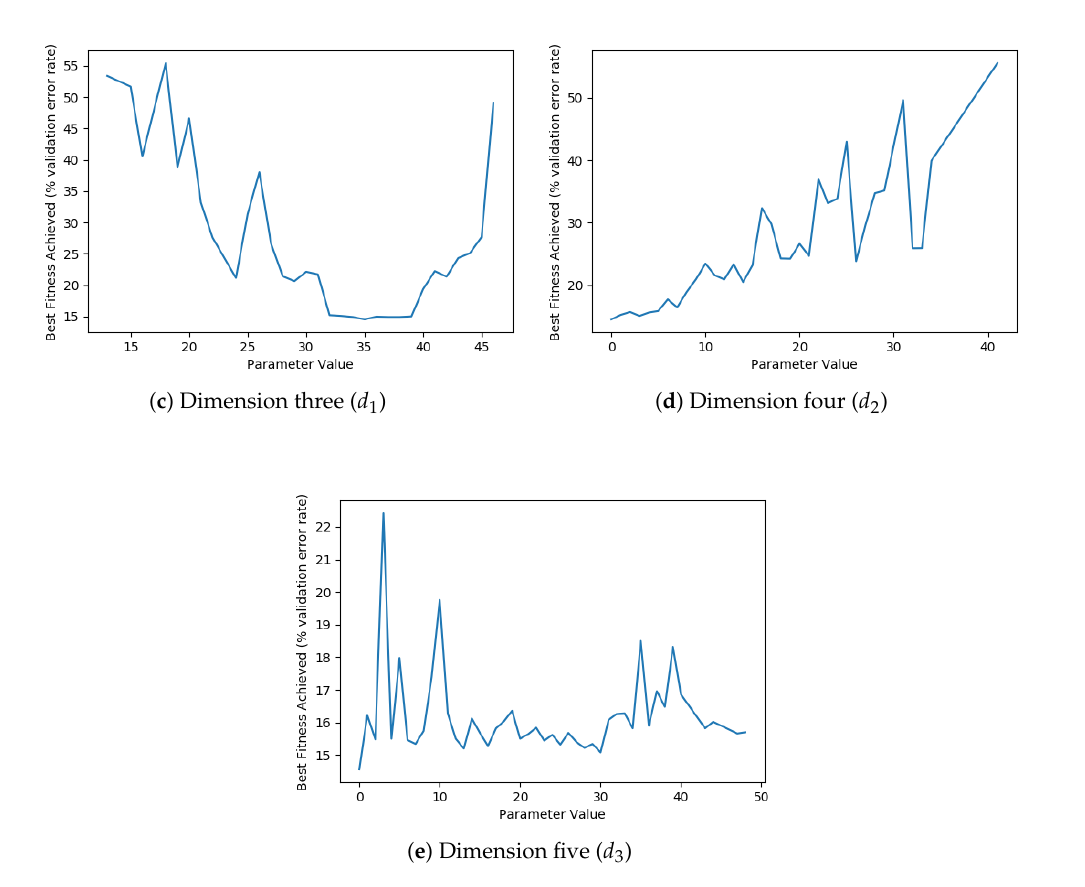
Figure 13. Visualisation of the best fitness scores achieved for different parameter values in each dimension using the BLSK-S weight inheritance method.